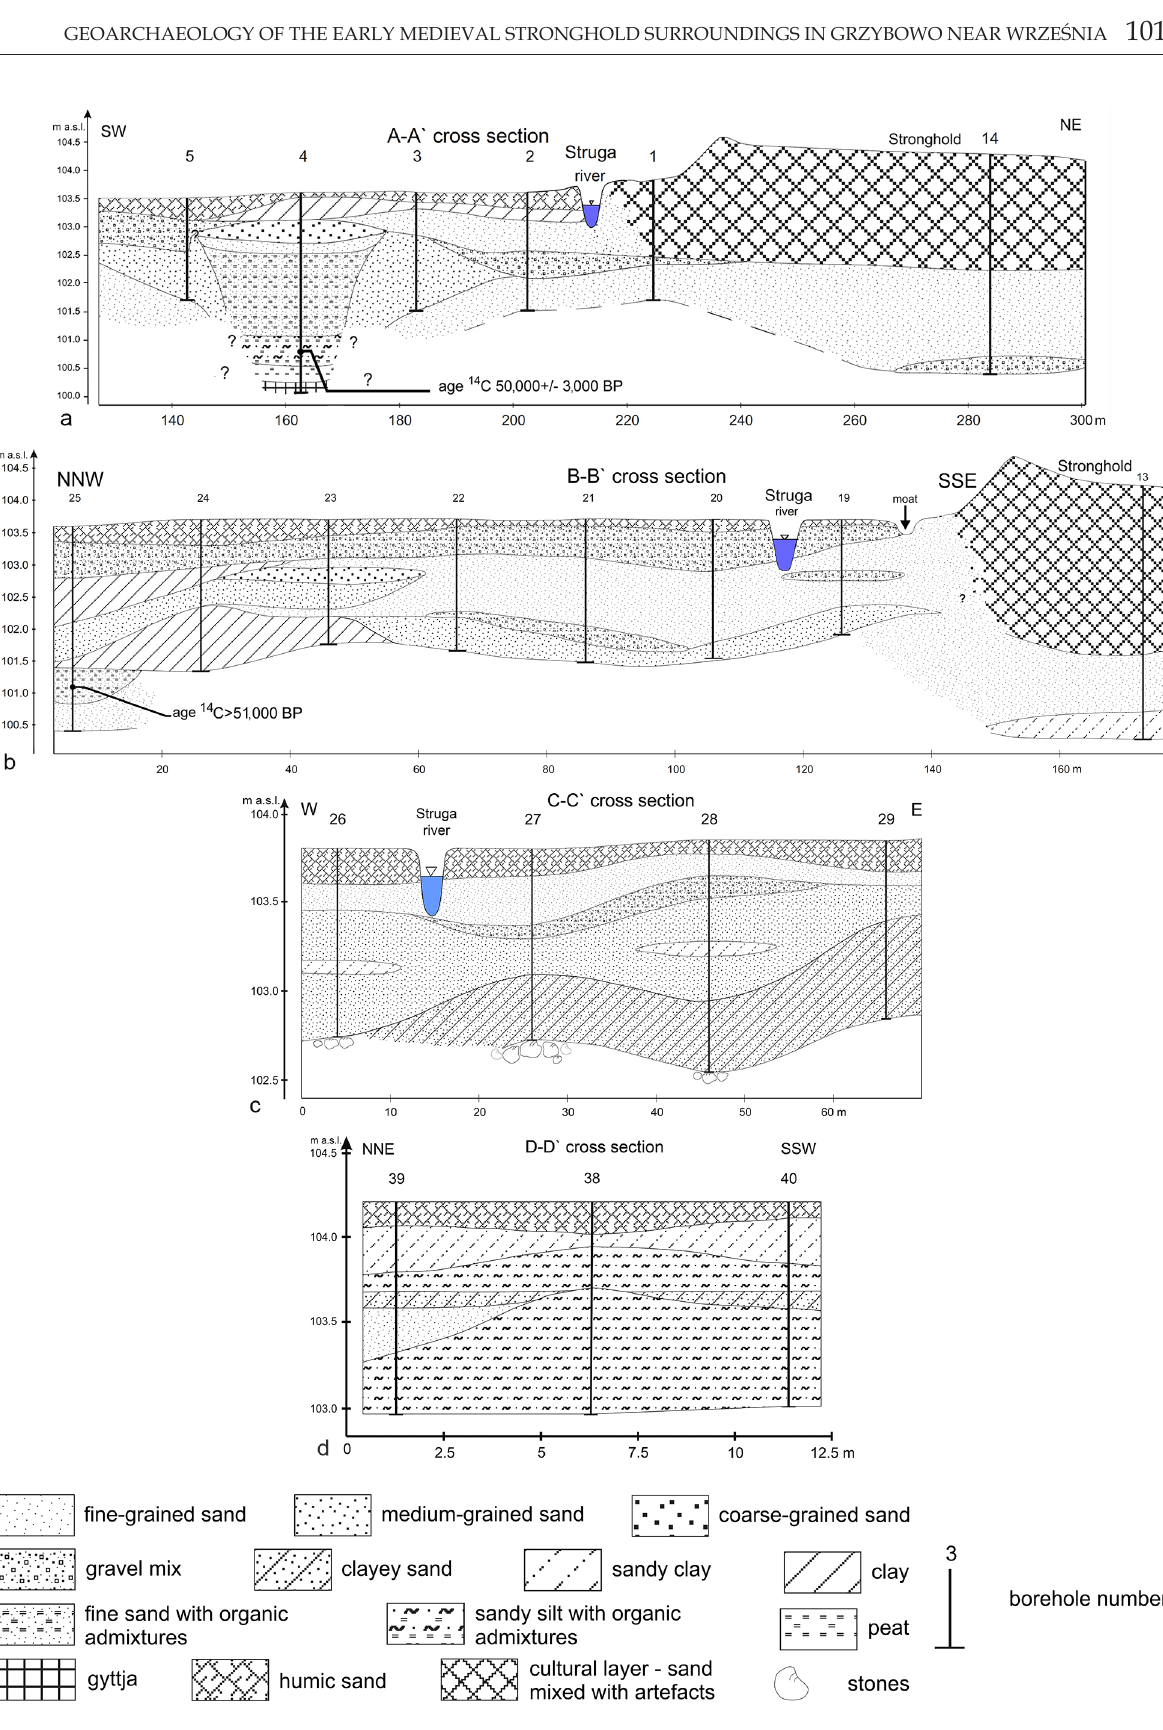
Fig. 5. Geological cross sections around the